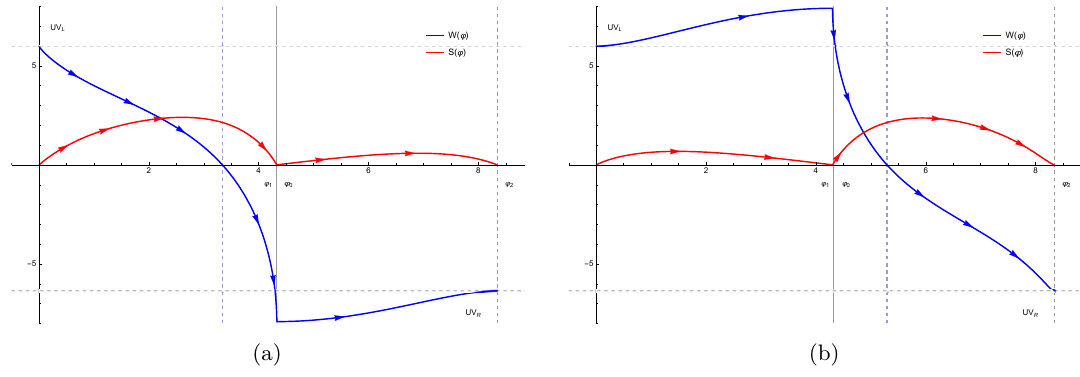
Figure 49 . As we move towards the left or right corners of the orange region in figure 10a the ( Max ) solution gradually tends to above solutions. (a): splitting of solution on the left or − , Max − a 1 ∩ a 4 corner. (b): splitting on the right or a 2 ∩ a 3 corner.